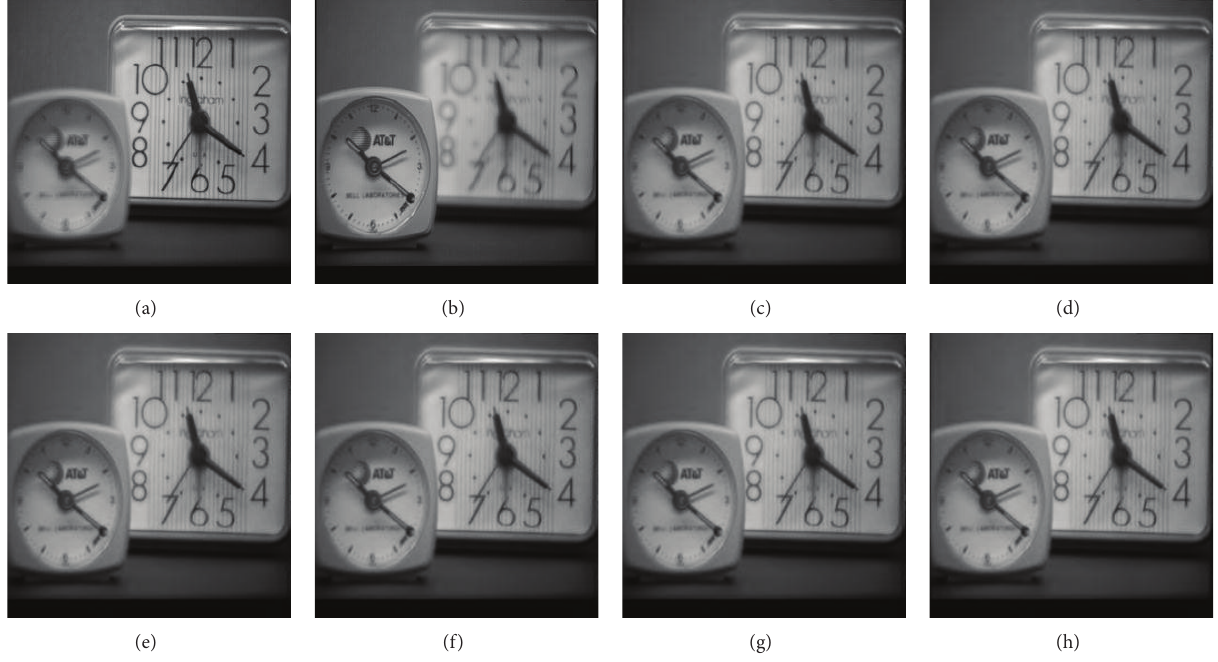
Figure 5: (a) Left-focus clock, (b) right-focus clock, (c) fusion result of average scheme, (d) fusion result of mean scheme, (e) fusion result of variance scheme, (f) fusion result of PCA scheme, (g) fusion result of MI scheme, and (h) fusion result of the proposed